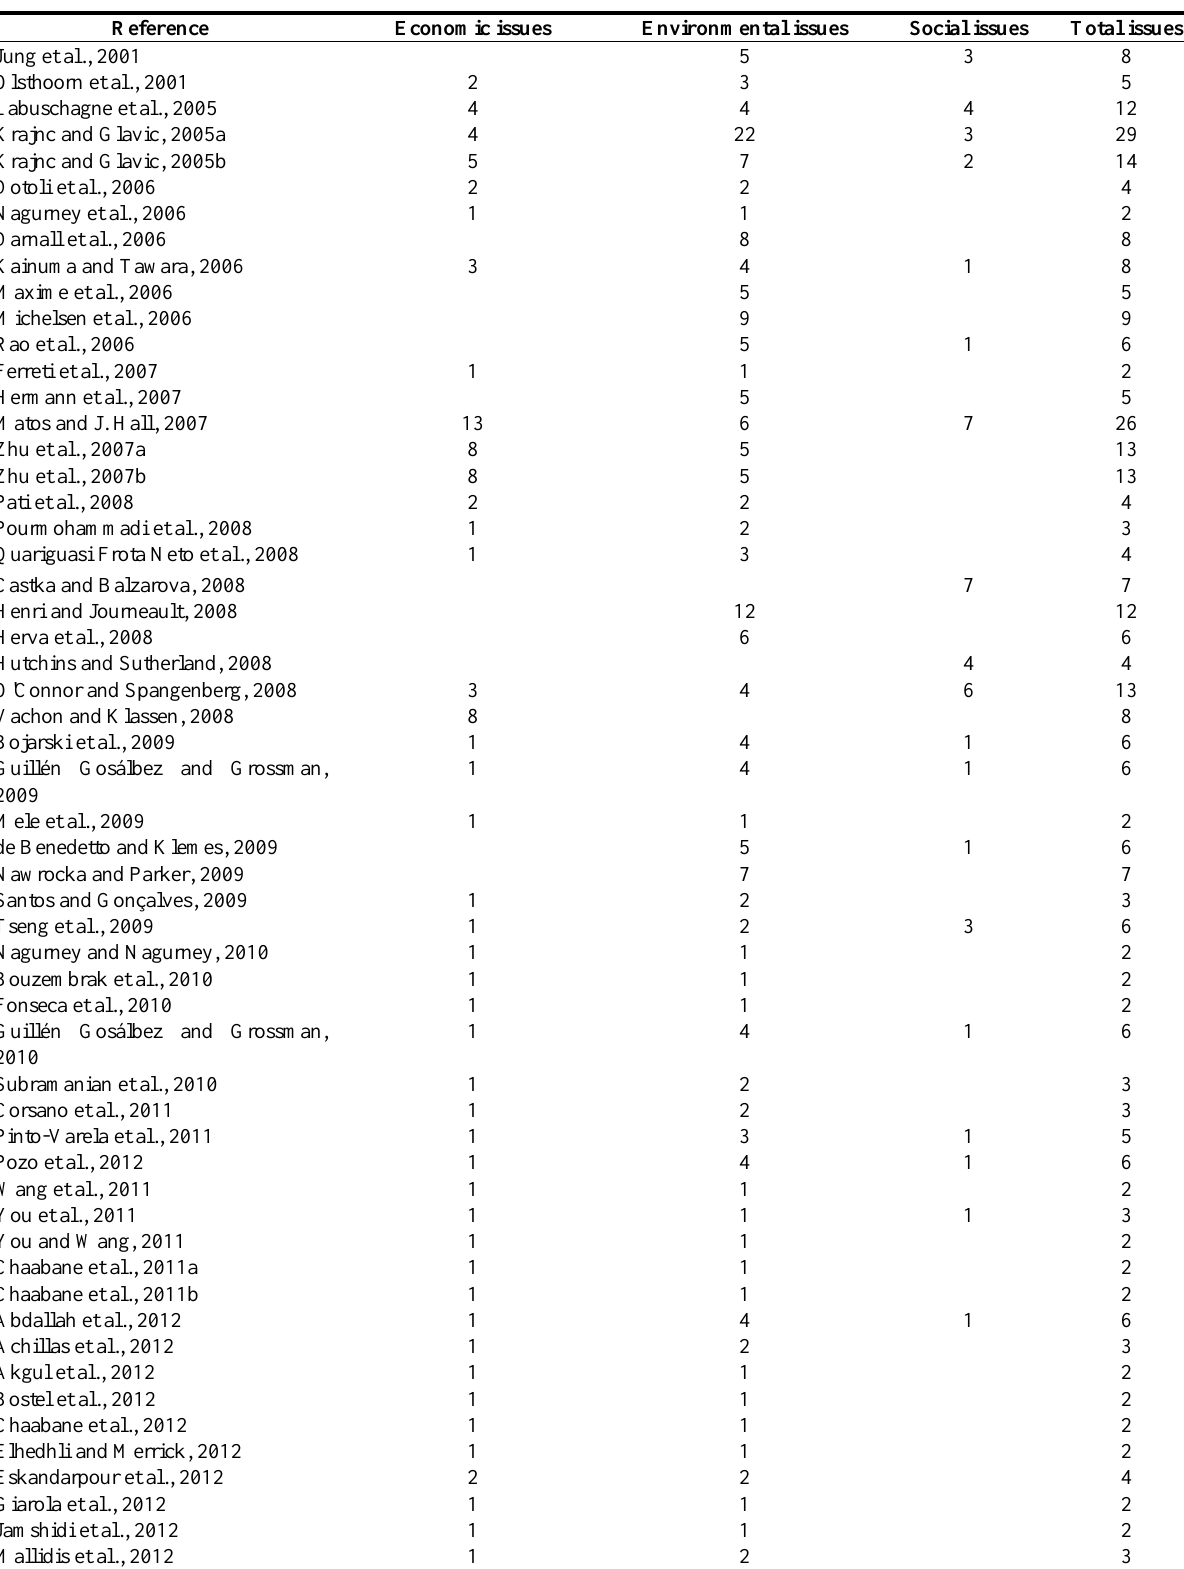
Table 1 (2) . Literature classification according to sustainable development